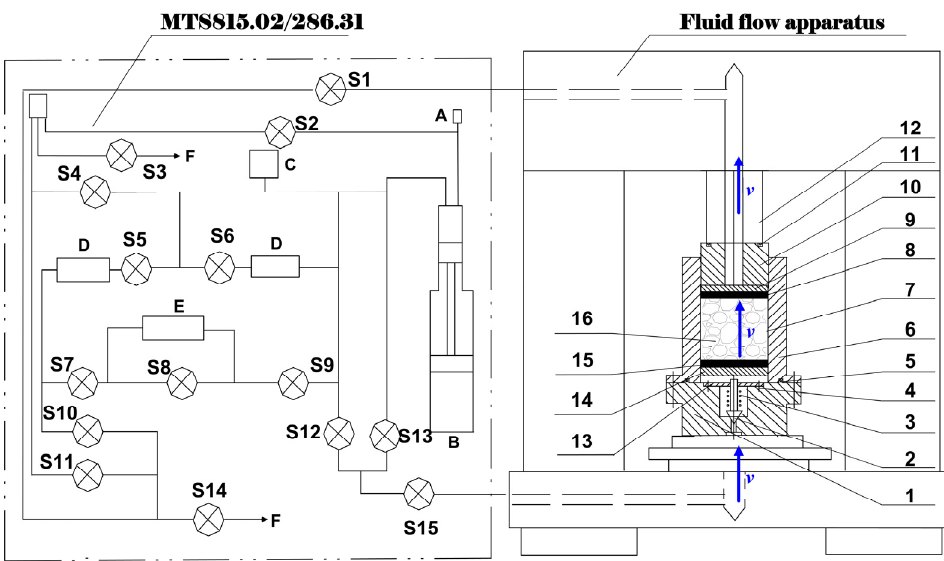
Figure 2. Testing system for non-cemented coal. Note: A—pressure sensor; B—load controller;